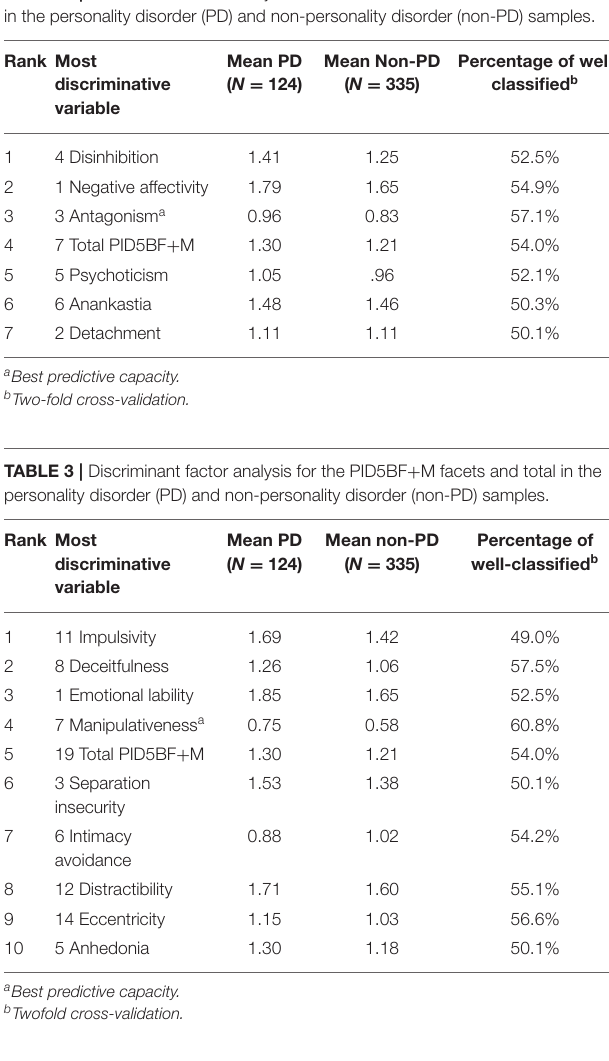
M trait domains and total +